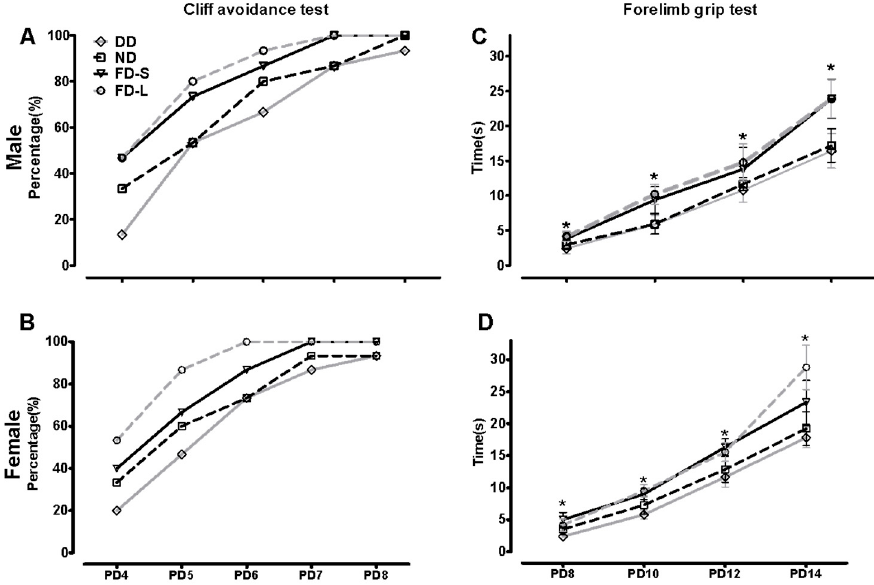
Figure 1. Maternal folic acid supplementation improved sensory-motor development in offspring. Dams were randomly assigned to a folate-normal diet group (ND), a folate-deficient diet group (DD), a folic acid-supplemented diet short-period group (FD-S), and a folic acid-supplemented diet long-period group (FD-L). Thirty pups (15 female and 15 male pups) were selected randomly from each diet group (4–5 offspring from each dam) for the cliff avoidance test at PD4-8 and the forelimb grip test at PD8-14. ( A ) Cliff avoidance test for male offspring ( n = 15/group); ( B ) Cliff avoidance test for female offspring ( n = 15/group); ( C ) Forelimb grip test for male offspring ( n = 15/group); ( D ) Forelimb grip test for female offspring ( n = 15/group). Data of cliff avoidance test are expressed as proportion, and data of forelimb grip test are expressed as mean ± SD. * Comparing with four groups at α = 0.05/(comparisons times).